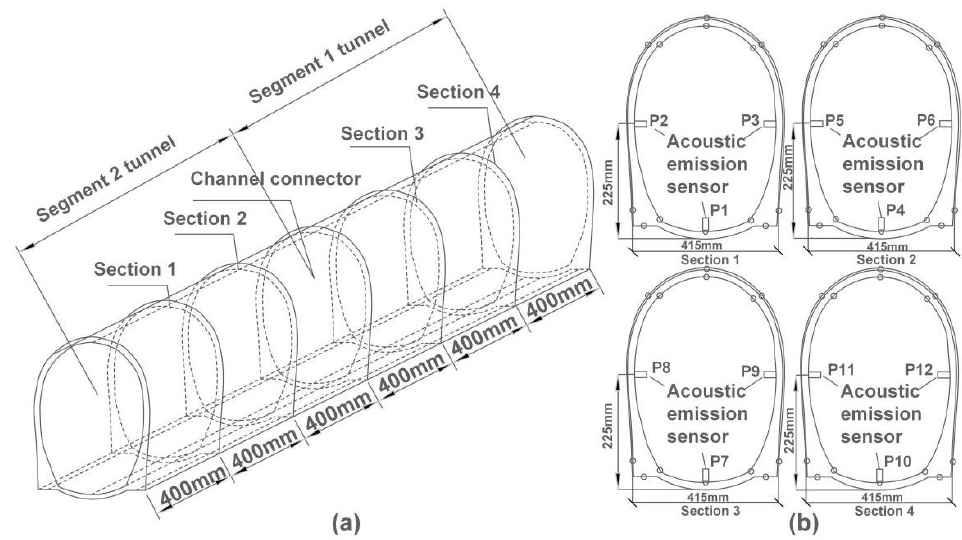
Figure 1. Schematic of experimental system: ( a ) side view of the model; ( b ) the overall design sche- matic of the experimental system; ( c ) the main view of the model.